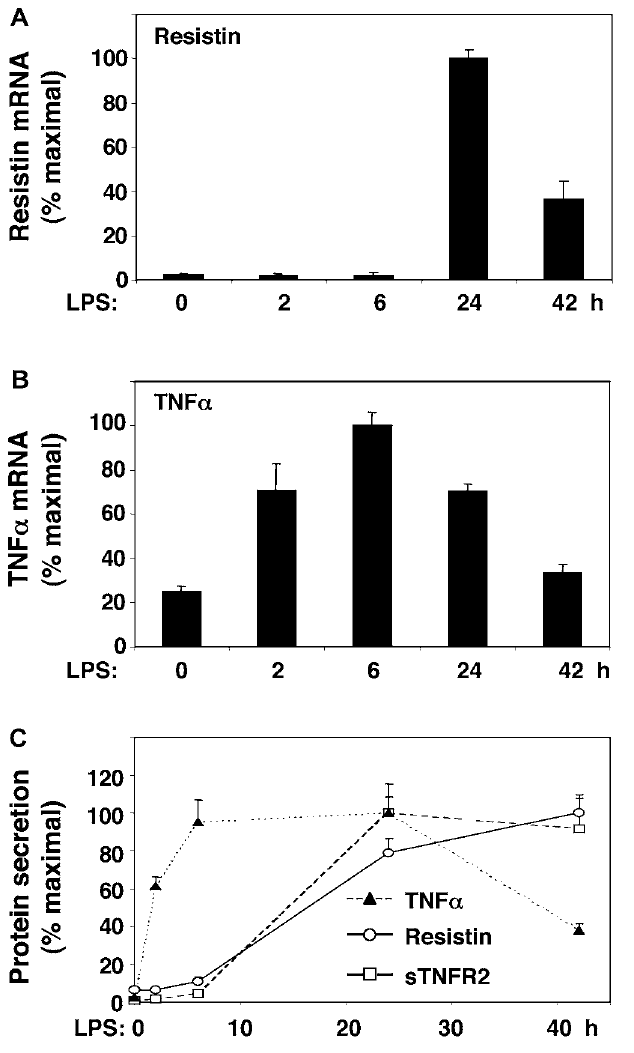
Figure 2. Endotoxin Induction of Resistin Occurs after Induction of TNF a Primary cultures of human macrophages were treated with LPS (1 l g/ ml) for various times.